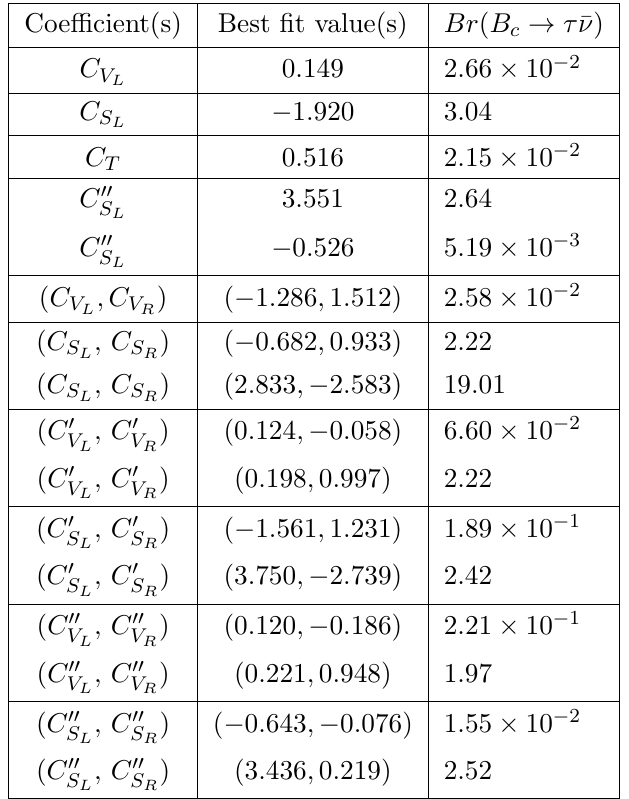
Table 3. Best (cid:12)t values of the coe(cid:14)cients of new physics operators at (cid:3) = 1 TeV for the measure- ments of R D , R D (cid:3) , R and P (cid:28) . Here we allow only those solutions for which (cid:31) 2 J= provide the predictions of branching ratio of B c ! (cid:28) (cid:22) (cid:23) decay for each solution. account for R . At present, there is no tension between R J=